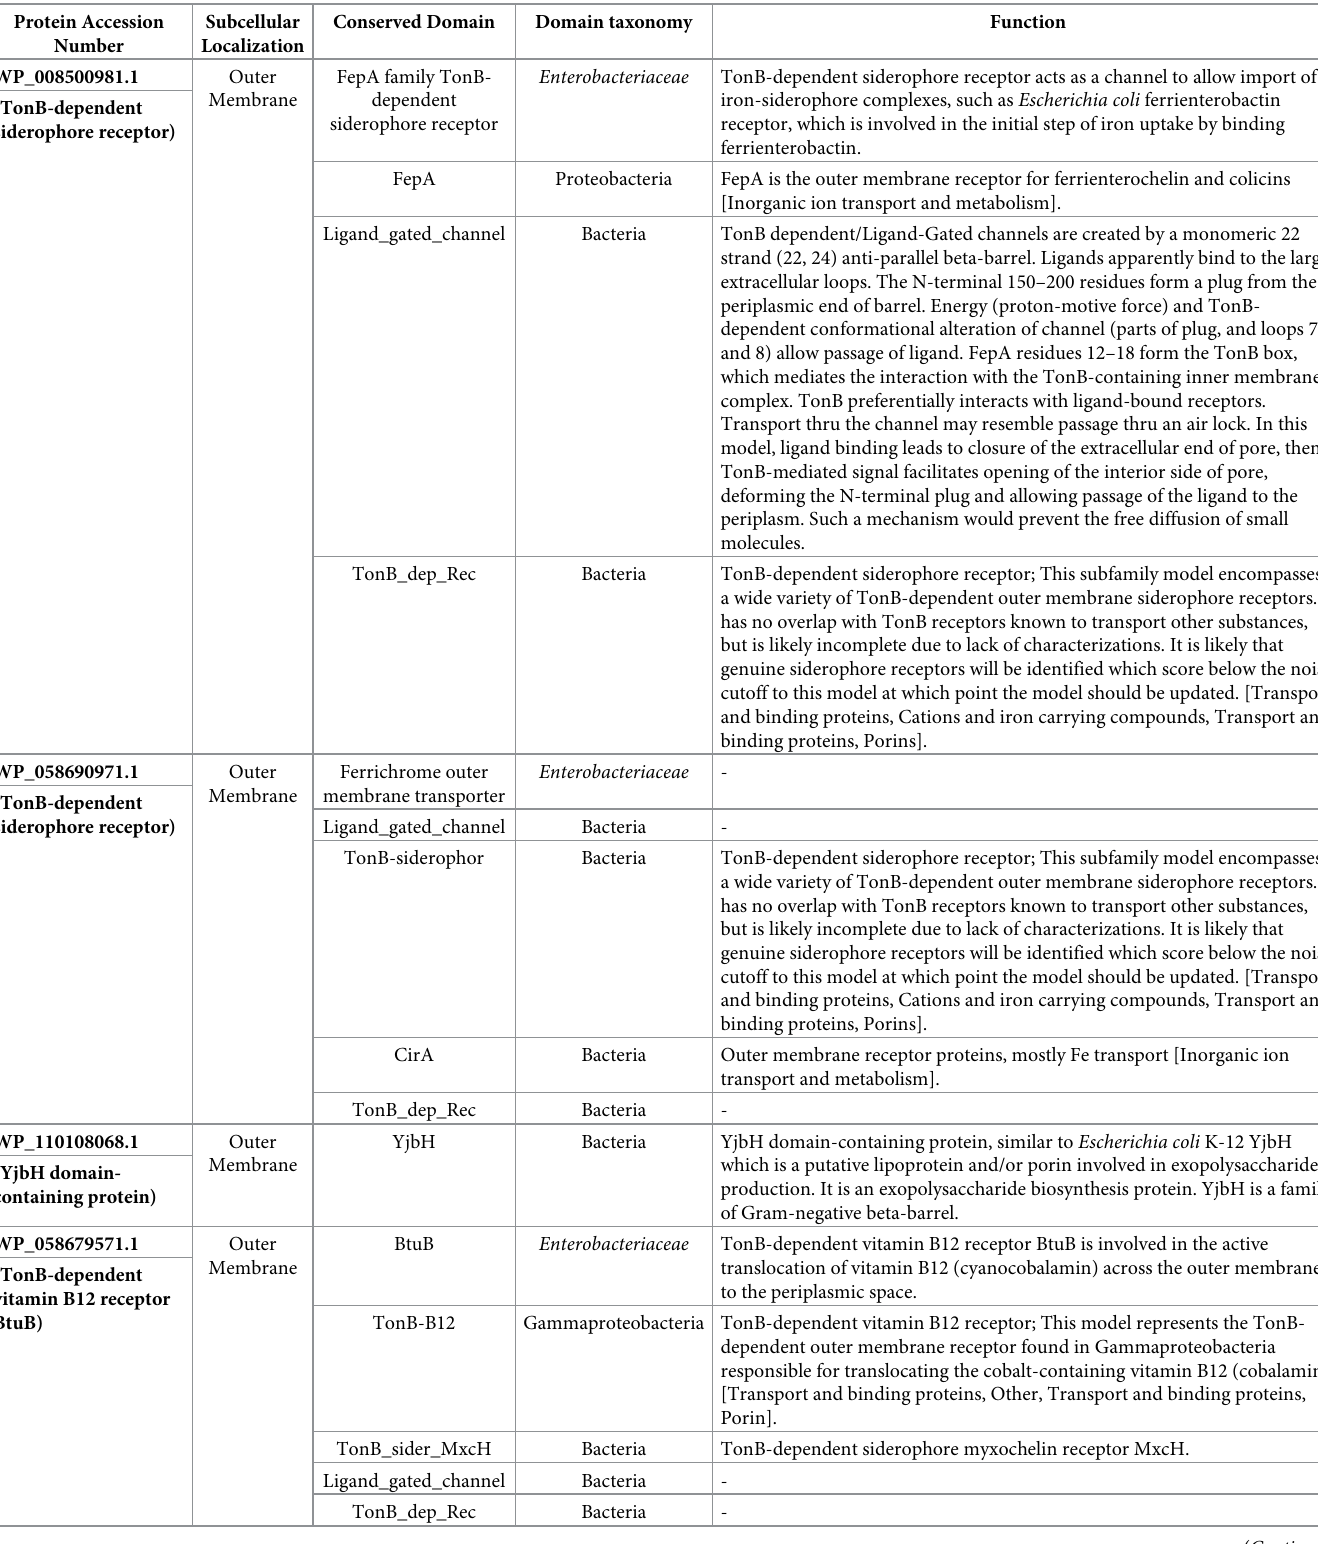
Table 2. Subcellular localization, conserved domains, related taxonomy and functions of nine putative vaccine candidates against clinical Enterobacter spp. Protein Accession